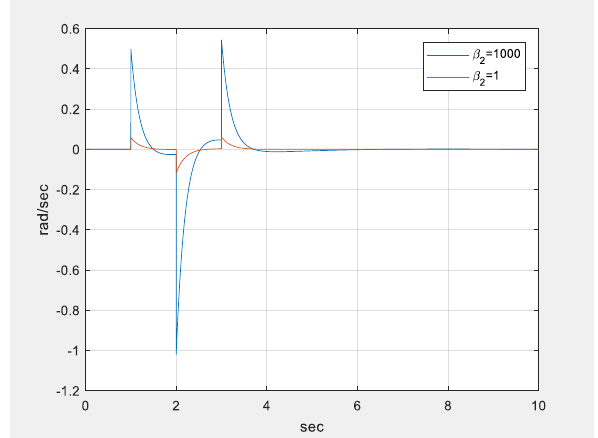
on angular velocity. 2